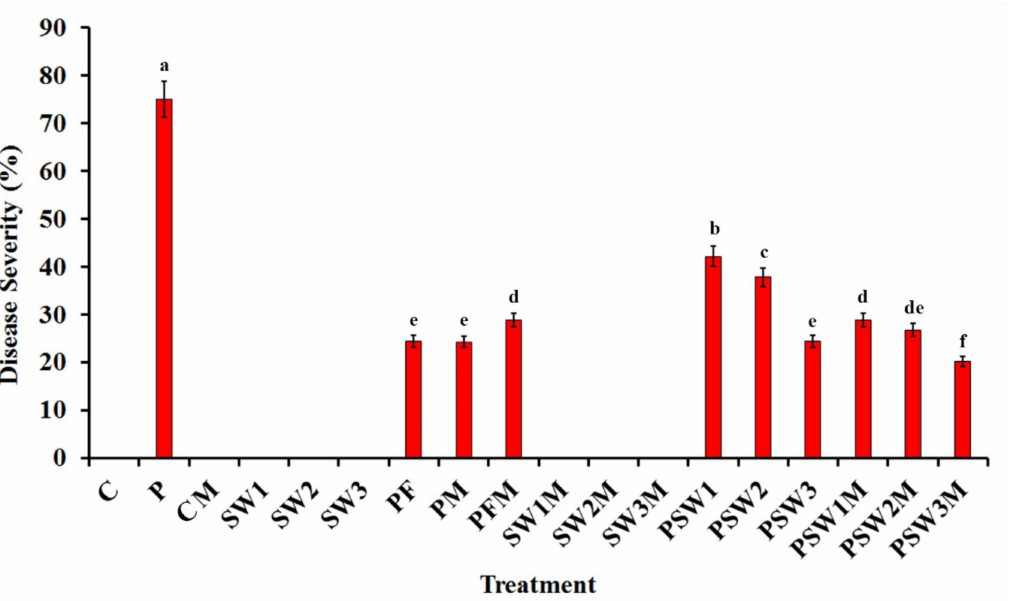
Figure 2. Histogram showing the disease severity in pea plants (cv. Master-B) infected with Rhi- zoctonia root rot in response to treating with seaweed extract and/or colonization with arbuscular mycorrhizal fungi at 20 days post inoculation. Where, C: uninfected and non-mycorrhizal, CM: uninfected and mycorrhizal, P: infected and non-mycorrhizal, PM: infected and mycorrhizal, PF: infected, non-mycorrhizal and treated with fungicide (Tendro 40% FS), PFM: infected, mycorrhizal, and treated with fungicide, SW1, SW2, and SW3: uninfected, non-mycorrhizal, and treated with the seaweed extract at 1, 2, and 3%, respectively, SW1M, SW2M, and SW3M: uninfected, mycorrhizal, and treated with the seaweed extract at 1, 2, and 3%, respectively, PSW1, PSW2, and PSW3: infected, non-mycorrhizal, and treated with the seaweed extract at 1, 2, and 3%, respectively, PSW1M. PSW2M, and PSW3M: infected, mycorrhizal, and treated with the seaweed extract at 1, 2, and 3%, respectively. Columns superscripted with the same letter are not significantly different according to Tukey’s HSD test at p ≤ 0.05. Each value represents the mean of ten replicates. Error bars represent standard